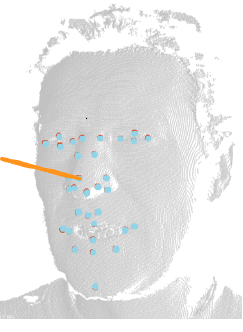
Fig. 1 Joint 3D head pose and facial landmark regression. Red points represent the ground truth shape while blue points represent the estimated shape. The orange axis indicates the head